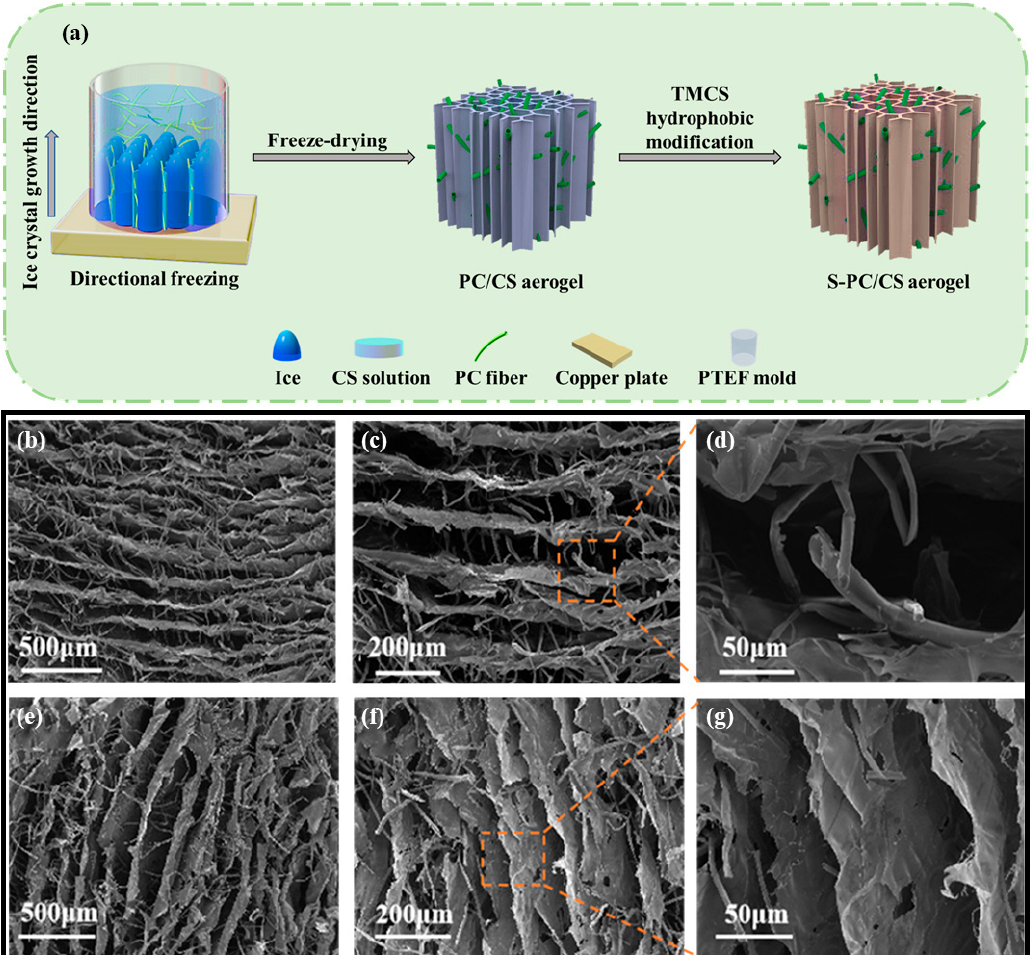
Figure 2. ( a ) Manufacturing process of S-PC/CS aerogel; ( b – d ) horizontally cu tt ing section and ( e – g ) vertically cu tt ing section of S-PC/CS aerogel.